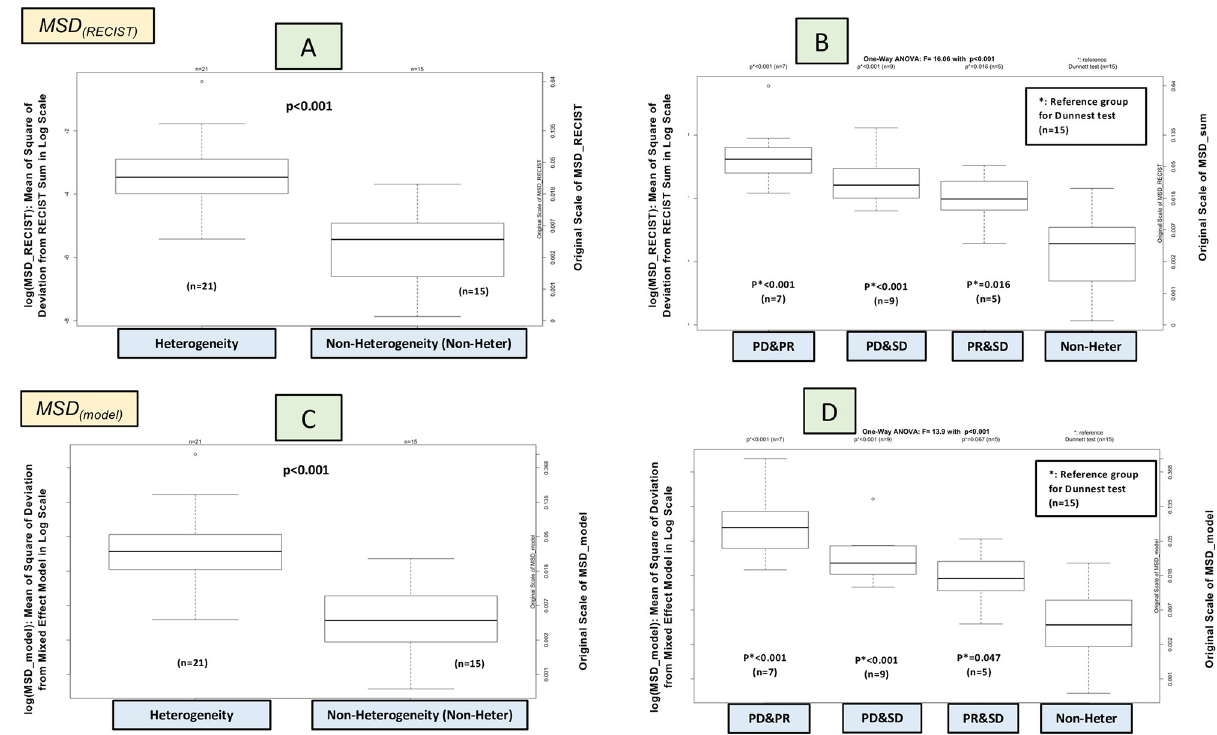
Fig 4. Comparison of MSD among lesion heterogeneous subgroups. PD&PR : mix of progression and regression; PD&SD : mix of regression and stability; PR&SD : mix of regression and stability; Non-Heter : non-heterogeneity.